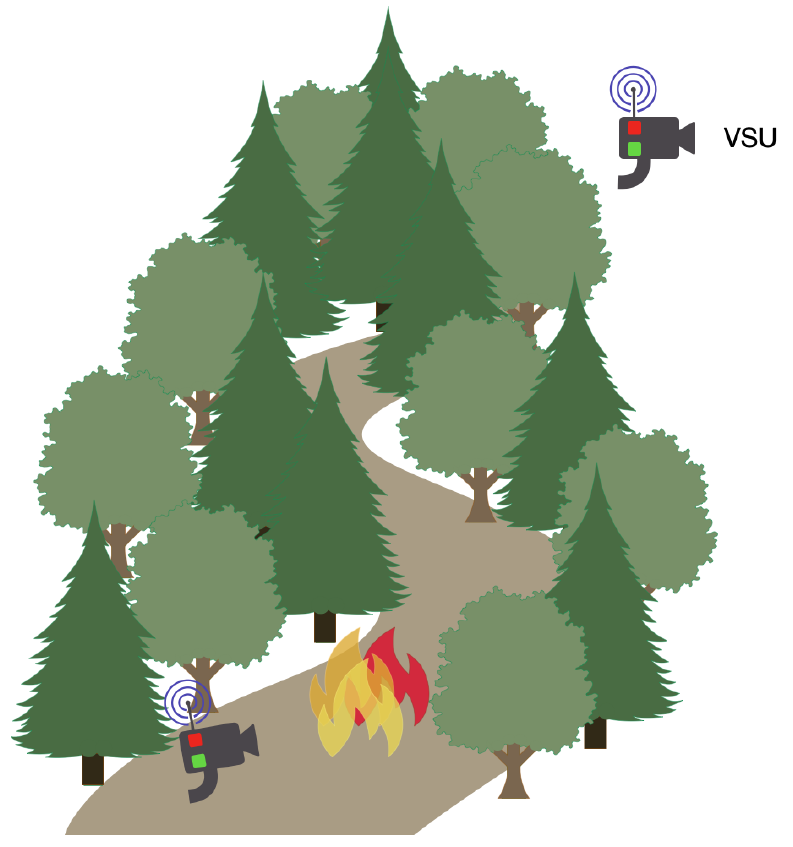
Figure 1. Application scenario of the prototype